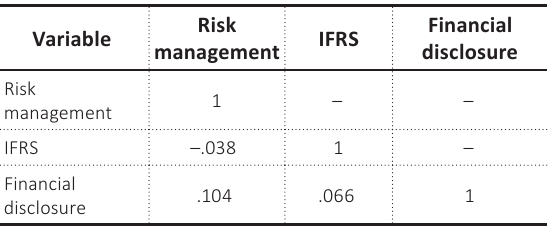
Table 2. Multicollinearity test